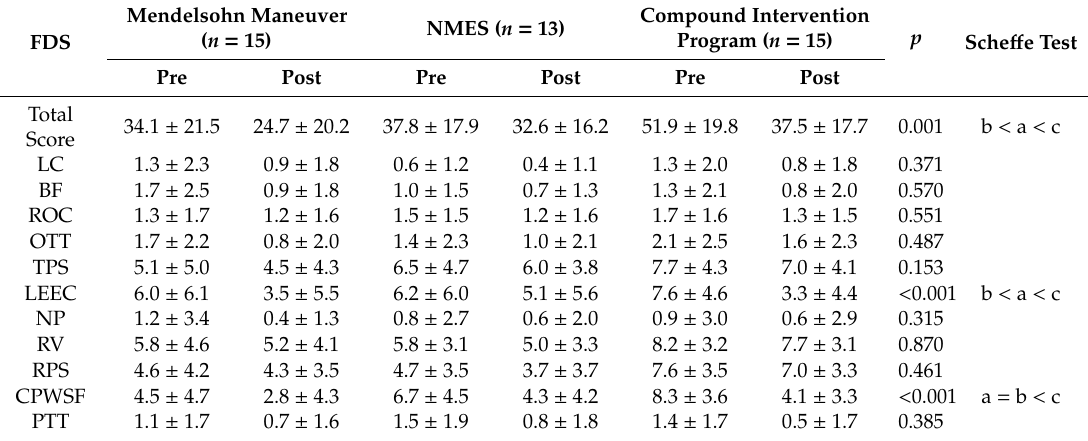
Table 4. Changes in the pre- and post-FDS scores of the Mendelsohn intervention group, the NMES group, and the compound intervention group, Mean ± SD.